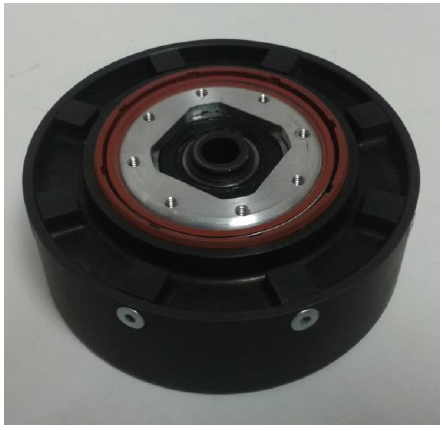
Figure 9. Aeronautical torque limiter project ready for testing.